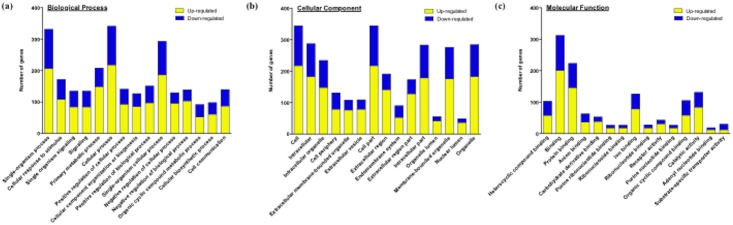
Gene ontology (GO) enrichment analysis of differentially expressed genes in bronchial smooth muscle tissues of the antigen-challenged mice.Total RNA sample of each mouse (4 animals, respectively) was subjected to the microarray analysis, and GO enrichment analysis of differentially expressed genes was performed. Top 15 significant GO terms for biological process (A), cellular component (B) and molecular function (C) are shown (adjusted p-value < 0.001 by Bonferroni). Each column represents the number of up- (yellow) and down-regulated (blue) genes in the indicated GO term.